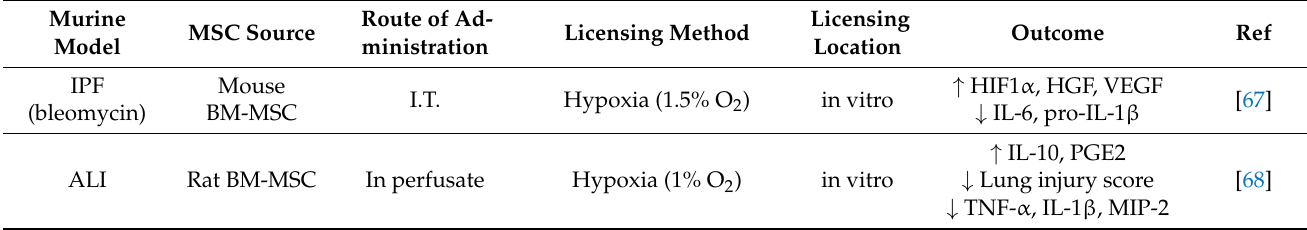
Table 1. Pre-clinical models of lung disease that received licensed